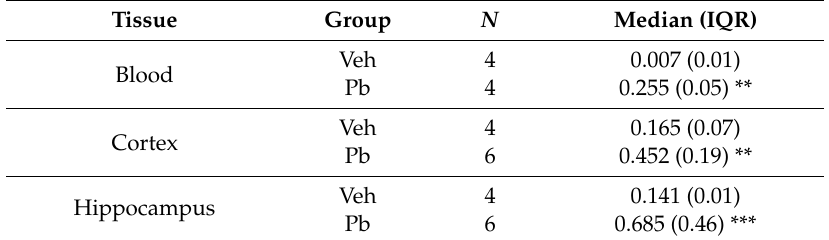
Table 1. Pb concentrations in blood ( µ g / mL) and brain tissues ( µ g / g) of o ff spring at post-natal day 23.